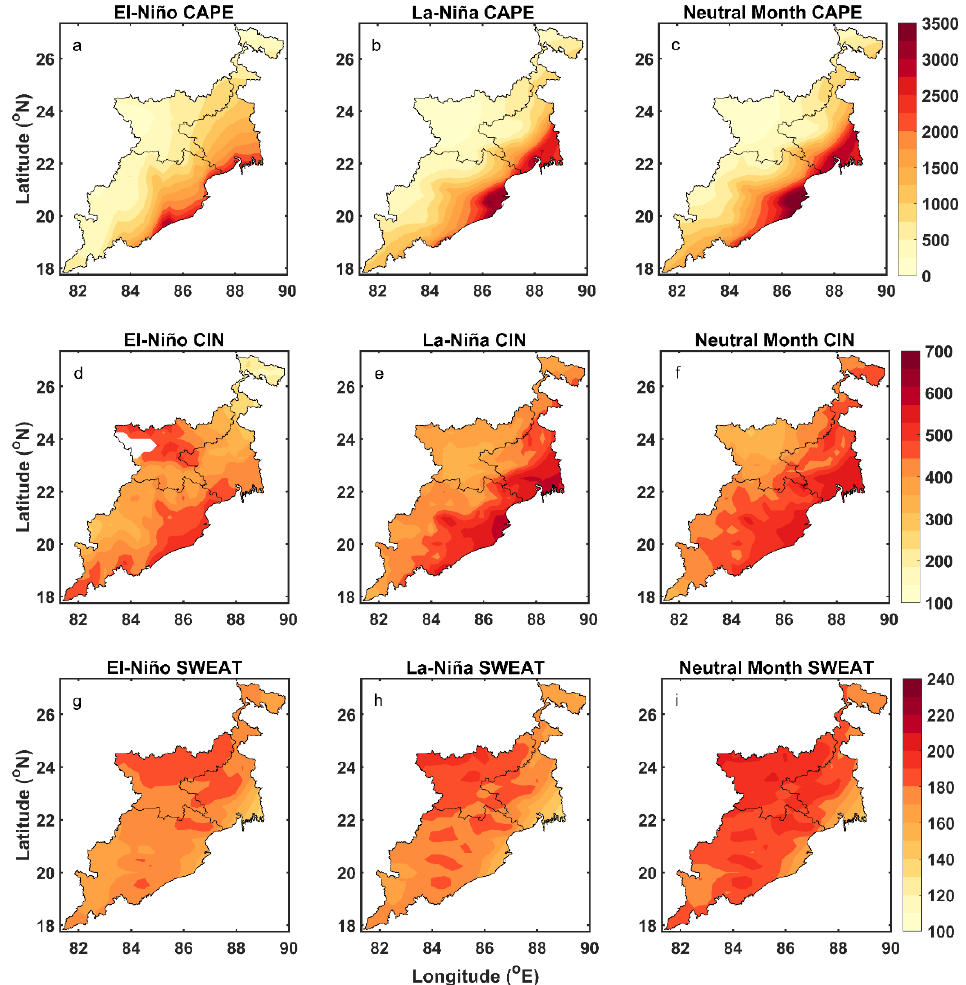
Figure 4. Variation of CAPE ( a ) El-Niño, ( b ) La-Niña and ( c ) Neutral months (first row), CIN ( d ) El-Niño, ( e ) La-Niña and ( f ) Neutral months (second row), and SWEAT ( g ) El-Niño, ( h ) La-Niña and ( i ) Neutral months (third row) during the pre-monsoon season from 1998–2014. The CIN values were higher during the La-Niña period. Odisha and West Bengal coastal areas of Odisha (~500–650 J/Kg), West Bengal (~550–650 J/Kg), and northern